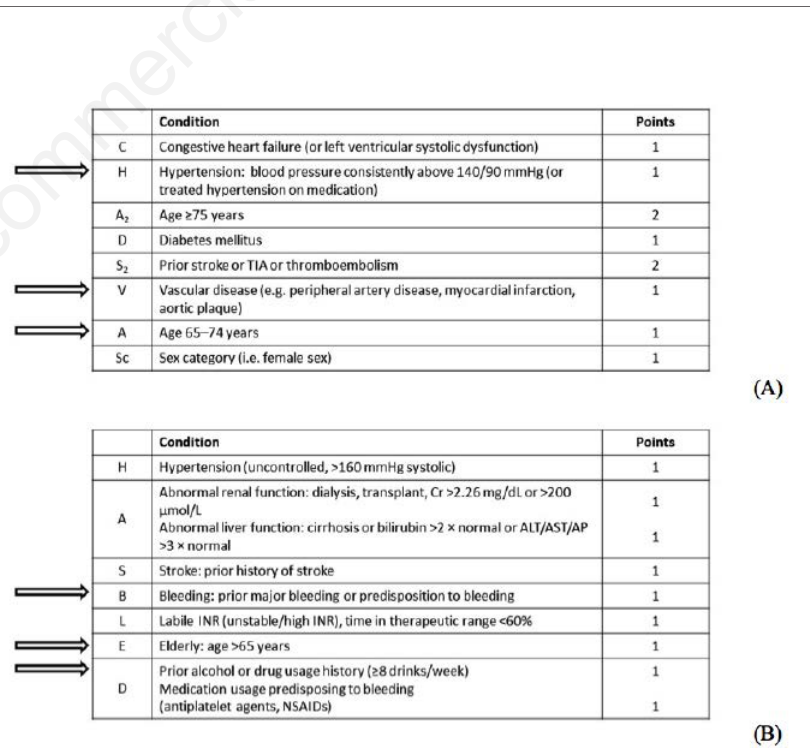
Figure 2. The patient’s (A) CHA2DS2-VASc score and (B) HAS-BLED score in March 2019. His risk factors are indicated by arrows. ALT, alanine aminotransferase; AP, alka- line phosphatase; AST, aspartate aminotransferase; Cr, creatinine; INR, international normalized ratio; NSAID, non-steroidal anti-inflammatory drug; TIA, transient ischemic